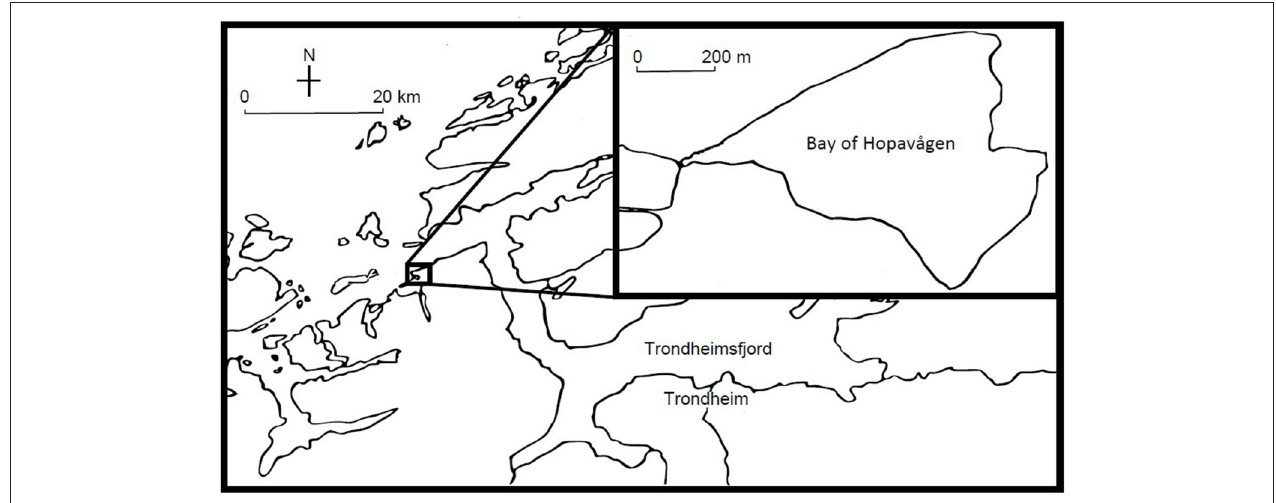
FIGURE 1 | The Bay of